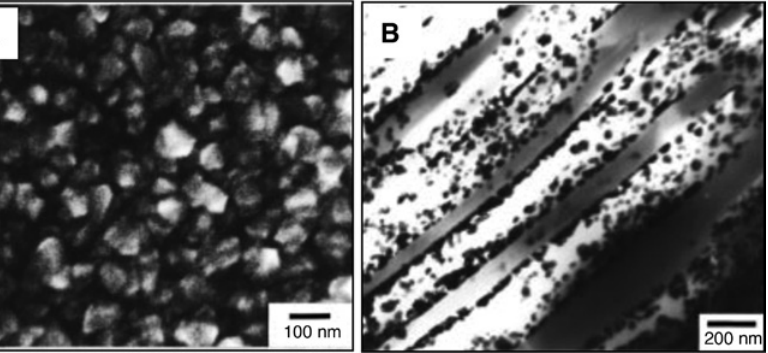
Figure 3: The first reported SFCD of metal Pt film onto silicon wafer (A) and porous alumina (B). Reprinted with permission from Watkins JJ, Blackburn JM, McCarthy ThJ, Chem. Mater. 1999, 11, 213–215 [33], Copyright 1999 American Chemical Society.